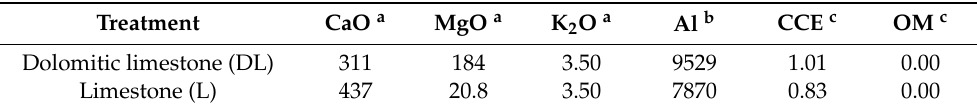
Table 4. Chemical composition of the liming materials expressed as dry matter ( n = 3). Treatment CaO